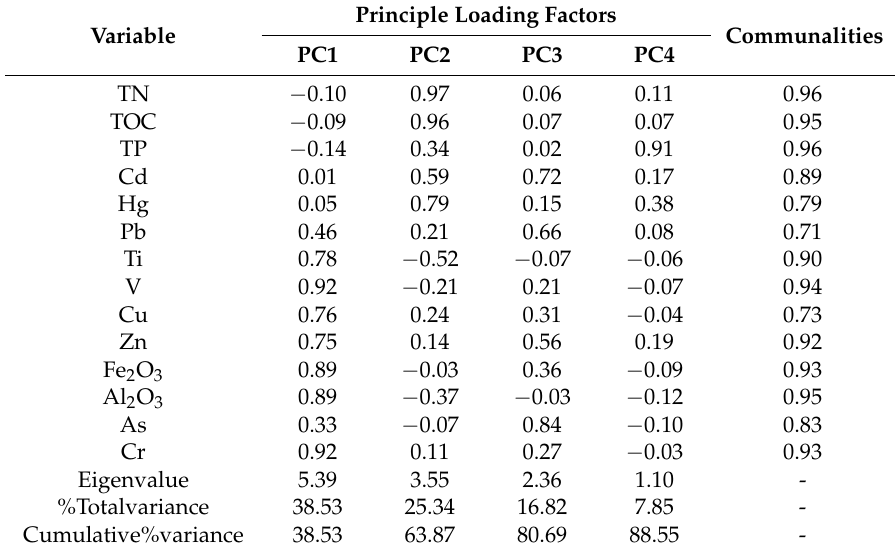
Table 3. Principle component analysis (PCA) for elements in the surface sediments of Nansi Lake.